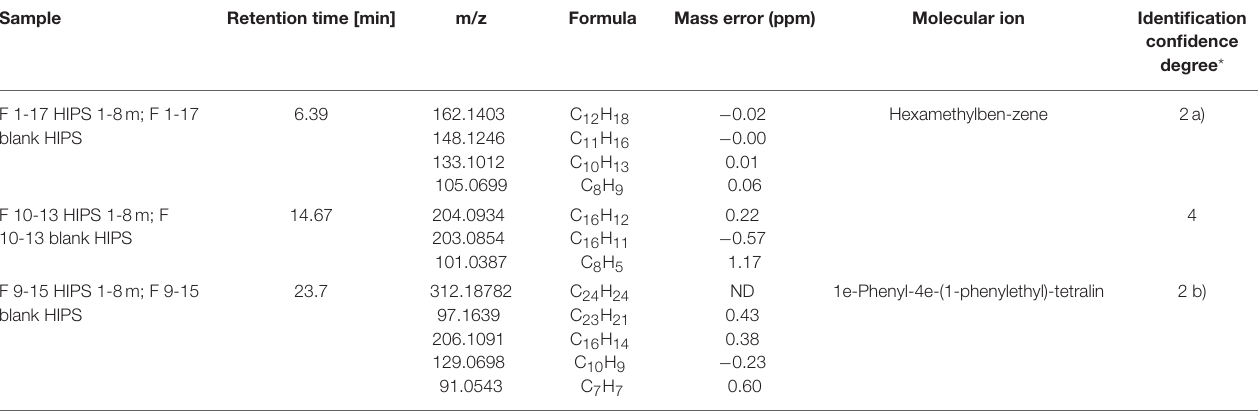
TABLE 1 | Detected major peaks ( > 10% base peak) in the total ion chromatograms (m/z 53.4–800) of fractions of deployed and blank plastic polymers detected by GC-HRMS. Sample Molecular